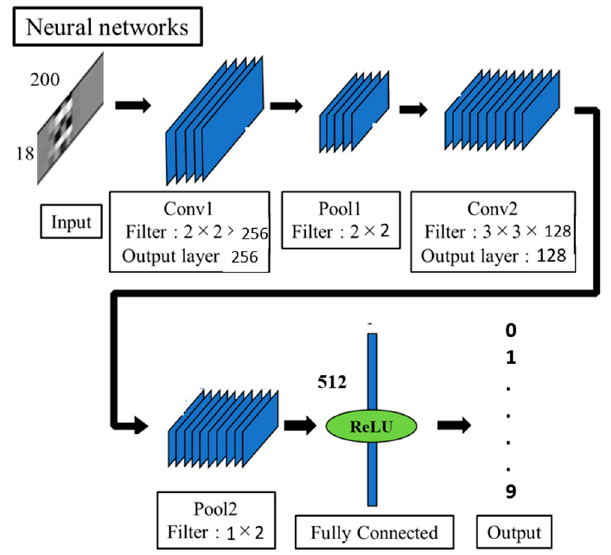
Figure 7. The architecture of CNN.